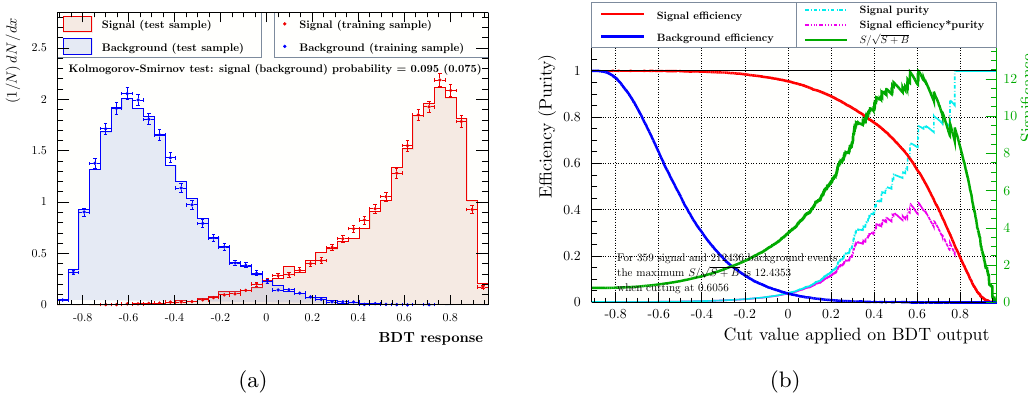
Figure 6 . (a) Normalized BDT response distributions for the signal and the background for the benchmark point BP1 . (b) Cut e(cid:14)ciencies as functions of BDT cut values. All plots are evaluated for benchmark point BP1 using integrated luminosity of 200 fb (cid:0) 1 at the 14 TeV LHC.